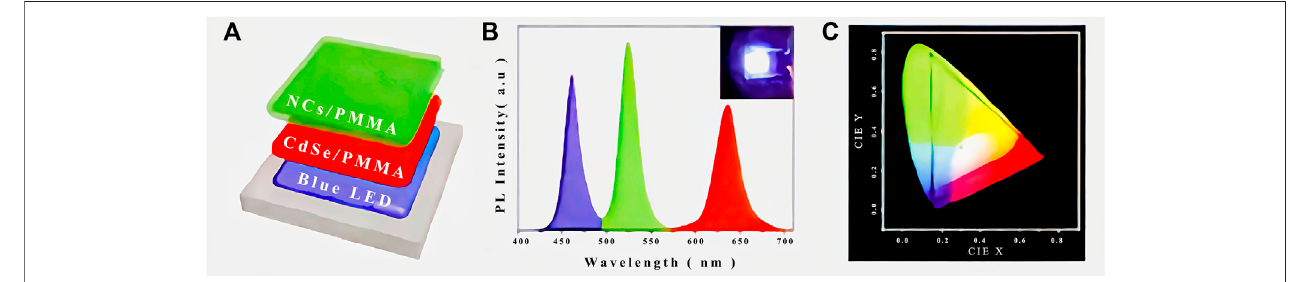
FIGURE 5 | (A) Schematic illustration of the con fi guration, (B) PL spectra (Inset shows a photograph of the device) and (C) CIE color coordinate of the CsPbBr3/ SiO 2 based WLED (Li et al.,